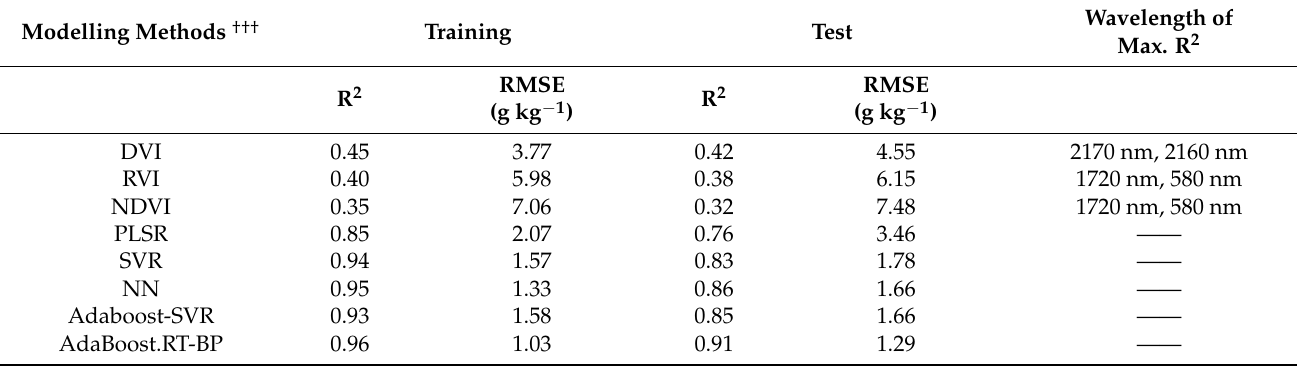
Table 4. Coefficient of determination and errors of training and test of nine modelling